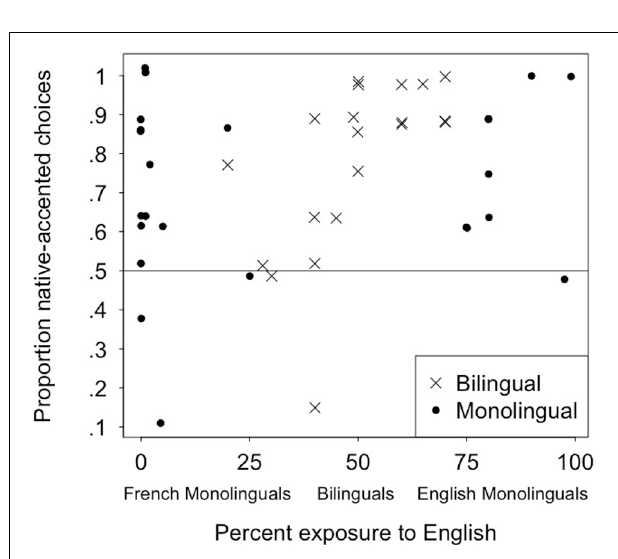
FIGURE 2 | Children’s preference for the native-accented speaker as a function of language exposure.